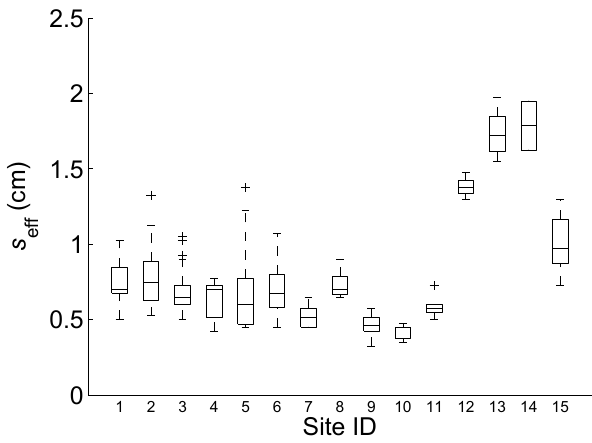
Fig. 3. Box plot of effective RMS heights ( s eff ) per site according to the index shown in Table 1.